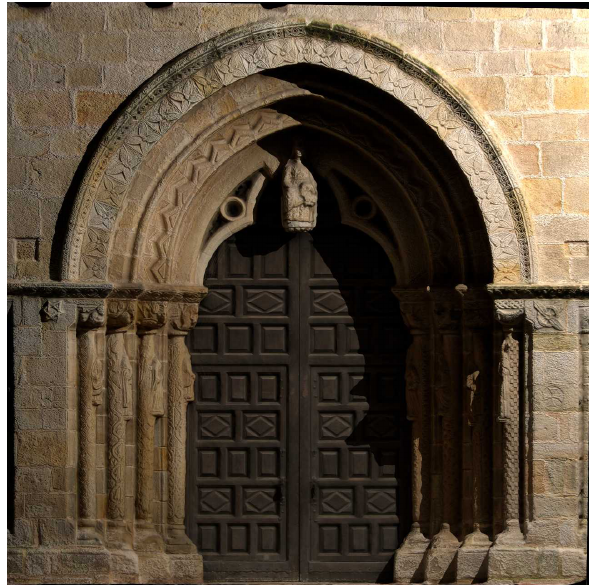
Figure 14: A synthetic render where there is a single point light source, to illustrate the hardness of the shadows when there is no significant environmental indirect light, in contrast with Fig.3.